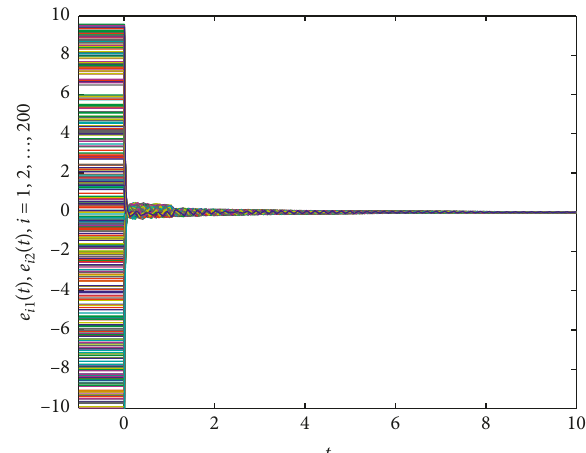
Figure 16: Time evolution of synchronization errors e under continuous feedback, i � 1 , 2 , ... , 200.